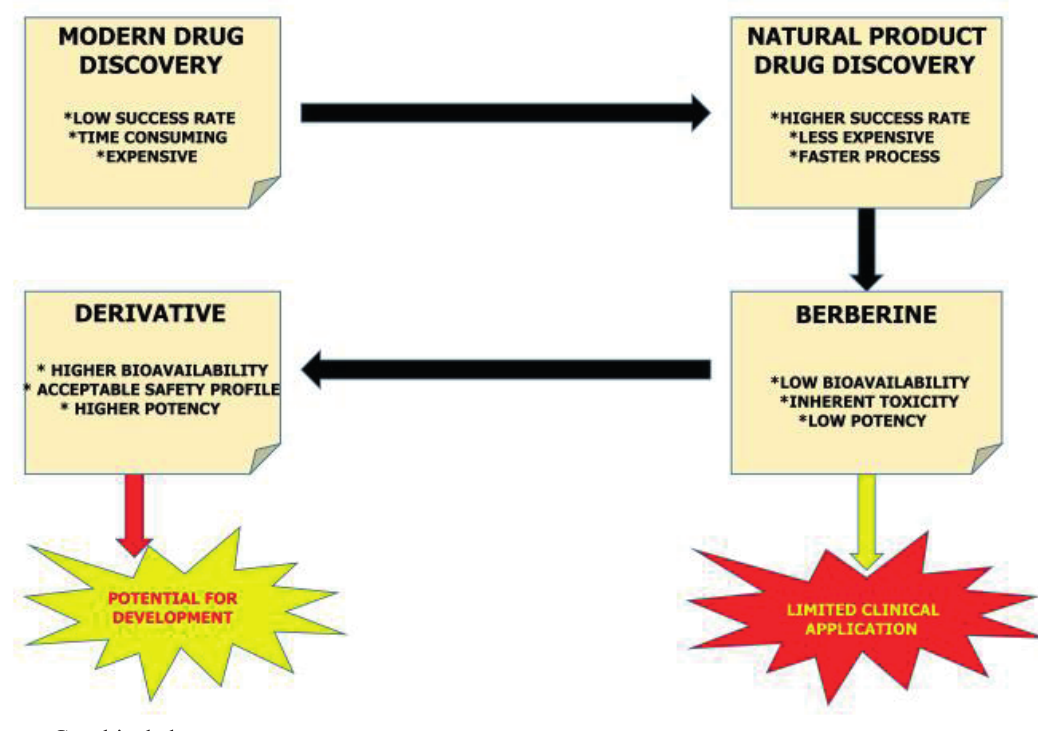
FIGURE 1 - Graphical